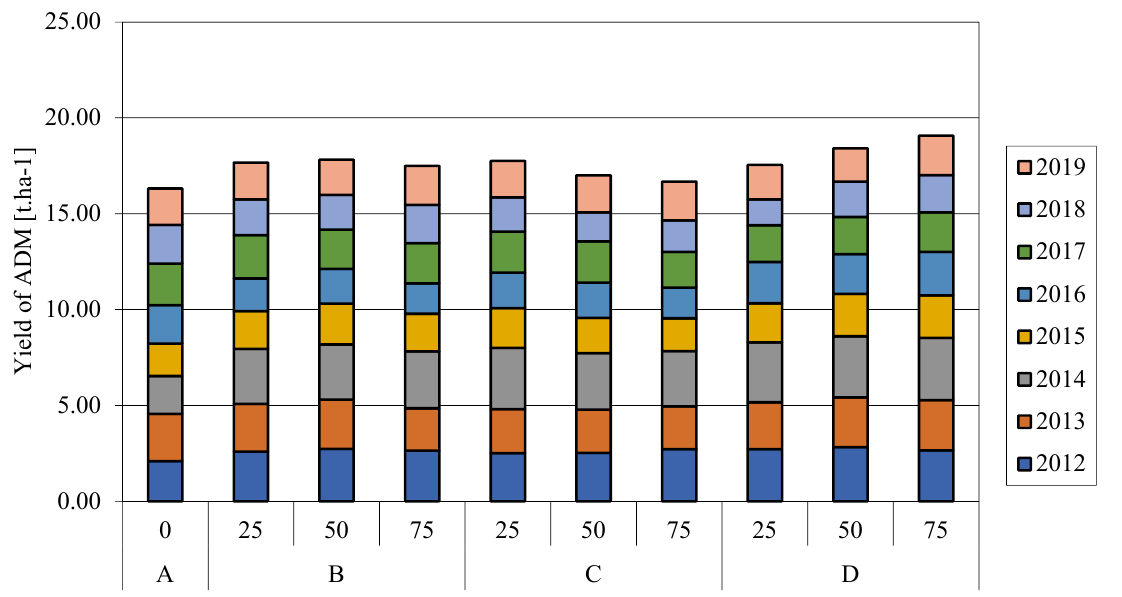
Figure 4. The influence of tillage equipment’s, reseeding norms and years of T. repens on the yield of ADM (Mean of pasture rotations). Tillage treatments: A—control object (without overseeding), B—underseeding after heavy tine harrow, C—underseeding after disc harrow, D—underseeding after the rotary tiller.